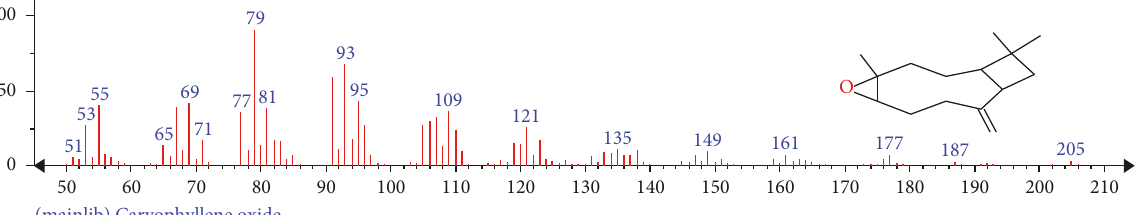
Figure 27: Mass spectrum of compound caryophyllene oxide of whole plant hexane fraction of Achillea wilhelmsii (WHFAW).